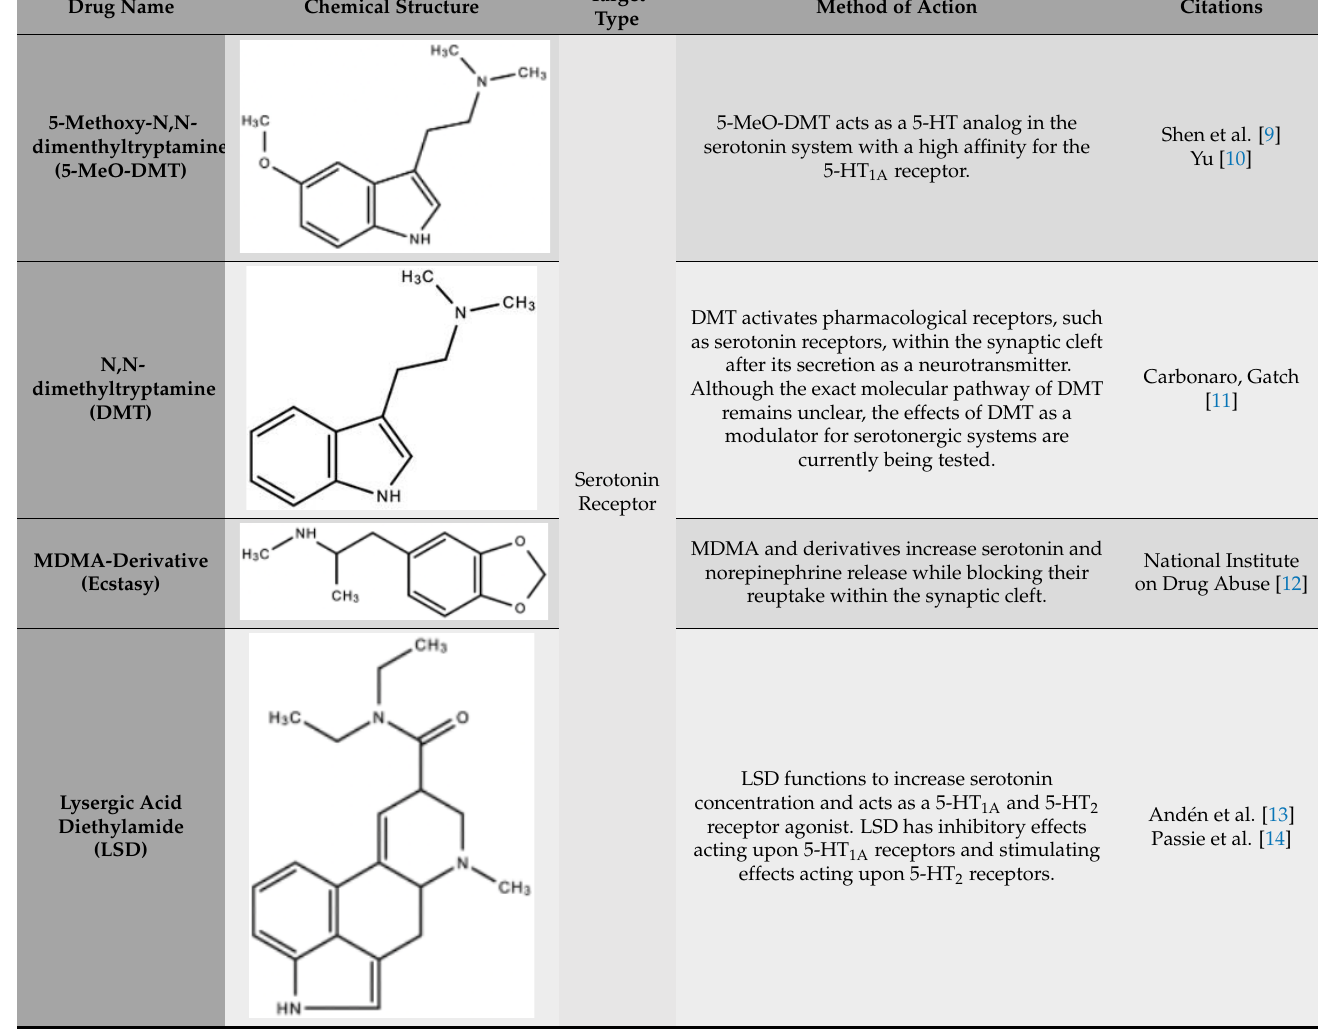
Table 1. Biochemical structures, mechanisms, and receptor functions of twenty psychoceutical